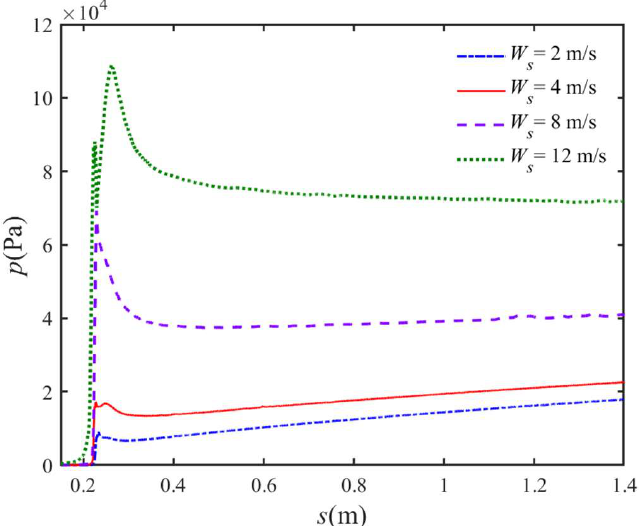
Figure 12. Comparison of the time history curve of monitored pressure for water entry of UAUV with various initial velocities.